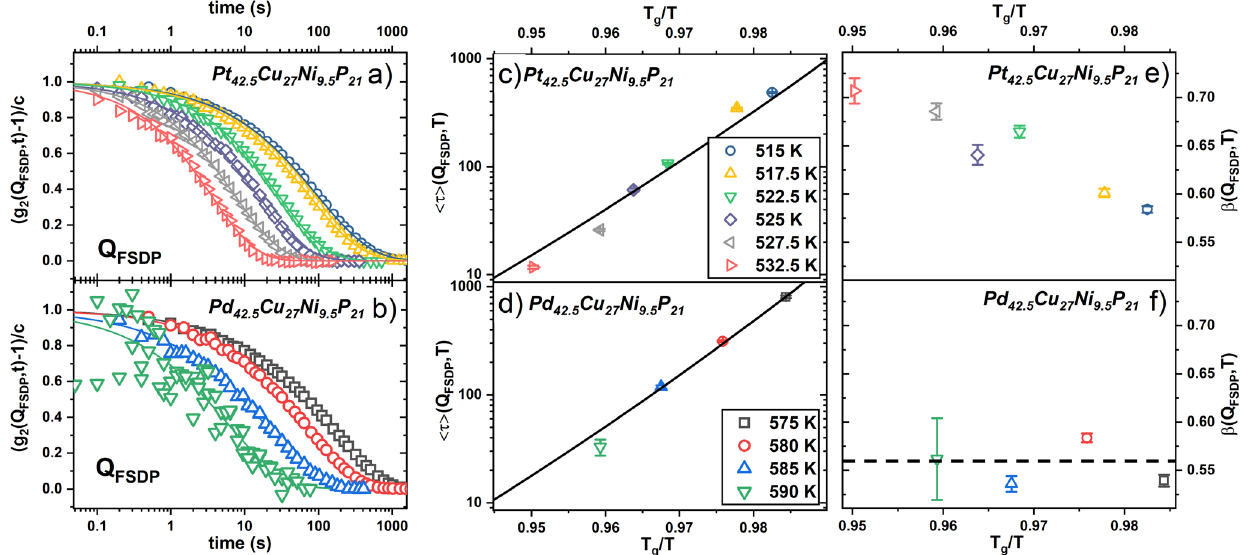
Fig. 1 Temperature dependence of the atomic dynamics in Pt 42.5 Cu 27 Ni 9.5 P 21 and Pd 42.5 Cu 27 Ni 9.5 P 21 supercooled liquids. a , b Normalized intensity autocorrelation functions measured at various temperatures for Pt 42.5 Cu 27 Ni 9.5 P 21 ( a ), and Pd 42.5 Cu 27 Ni 9.5 P 21 ( b ) at the wave vector Q of the fi rst sharp diffraction peak (Q FSDP ≈ 2.8 Å − 1 for both systems). c , d Mean relaxation time < τ (Q,T)> of the Pt- and Pd-based alloys measured at the position of the fi rst sharp diffraction peak Q FSDP at various temperatures T. The solid lines are fi ts to the Vogel-Fulcher-Tammann equation (see section “ Collective particle motion in the supercooled liquid phase ” ). e , f Temperature dependence of the corresponding exponent of the Kohlrausch-William-Watts equation β (Q,T) for Pt 42.5 Cu 27 Ni 9.5 P 21 ( e ) and Pd 42.5 Cu 27 Ni 9.5 P 21 ( f ). The dashed line is a guide to the eyes. Error bars indicate the standard error due to fi tting of the experimental data using the Levenberg Marquardt